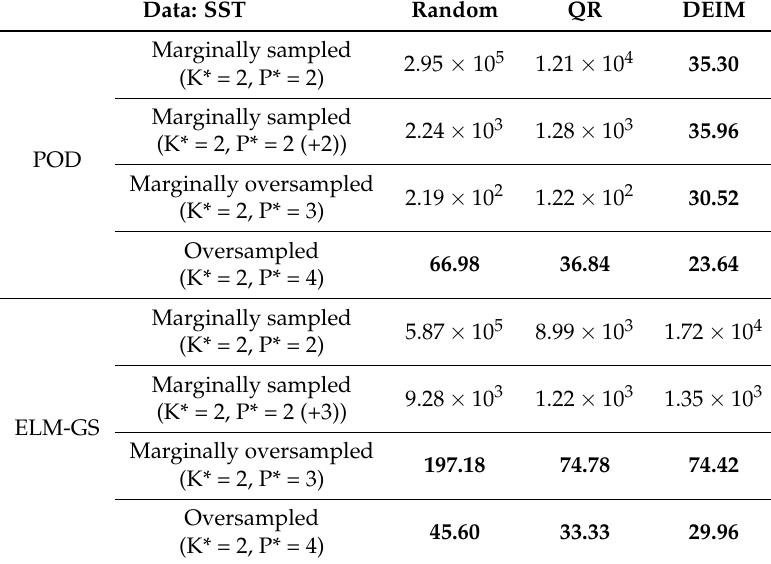
Table 2. Condition number estimation of Θ T Θ for both POD and ELM-GS basis-based SR using different sensor placement methods on sea surface temperature (SST) data. We have bolded the metrics smaller than a cutoff of 200 to highlight the low condition number